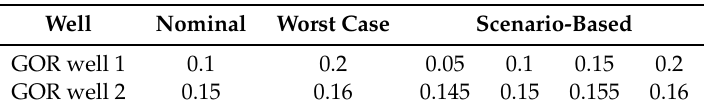
Table 2. GOR (Gas-Oil ratio) values used in the optimizer for nominal, worst case and scenario-based approach.